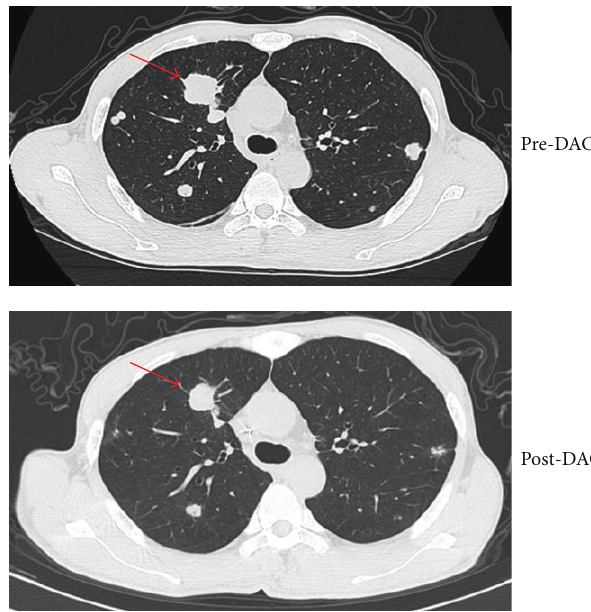
Figure 3: CT image for UPN 20 exhibited a partial response. A CT image showing the specific characteristics of the response of lung lesion following four cycles of decitabine treatment, assessing by the Response Evaluation Criteria in Solid Tumors (RECIST). The red arrows indicate the areas of measurable